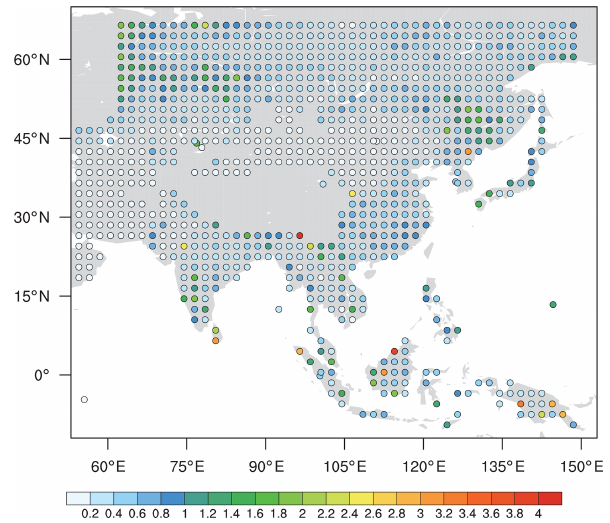
Figure 6. The spatial distribution of self-sensitivities (%) during the experimental period obtained from the ALL experiment.